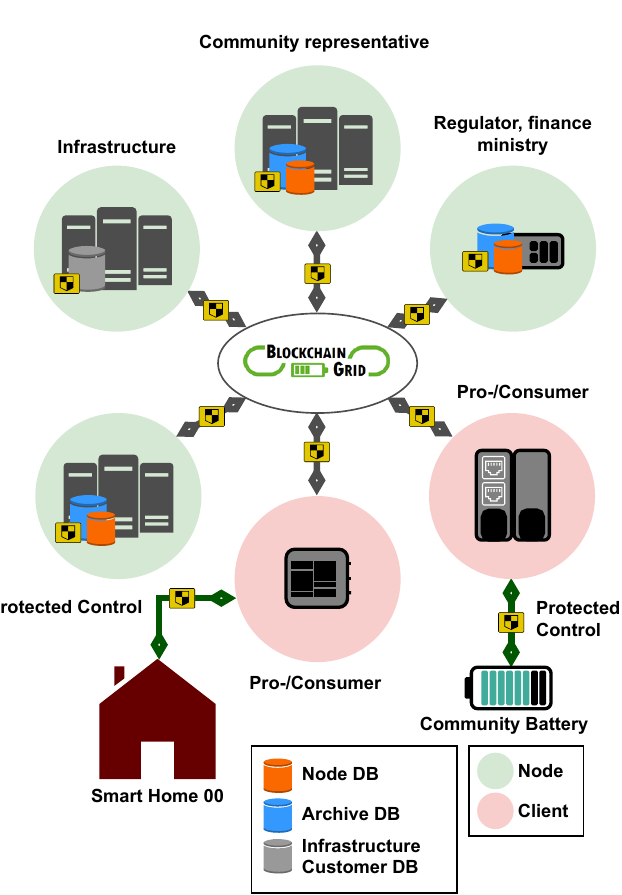
Figure 1. Blockchain System Architecture implemented in the BlockchainGrid project at the LEC in